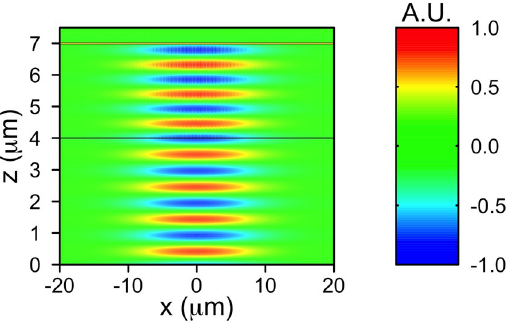
Figure 11. Electric field along the y axis, E y , of the Gaussian beam injected at z = 0 and propagating through the three regions of the device: glass (0 < z < 4 μ m), LC (4 < z < 7 μ m) and gold coated glass (7 < z < 7.5 μ m). The gold coating is at z = 7 μ m and the wavelength is λ = 1.55 μ m. E y is plotted using arbitrary units